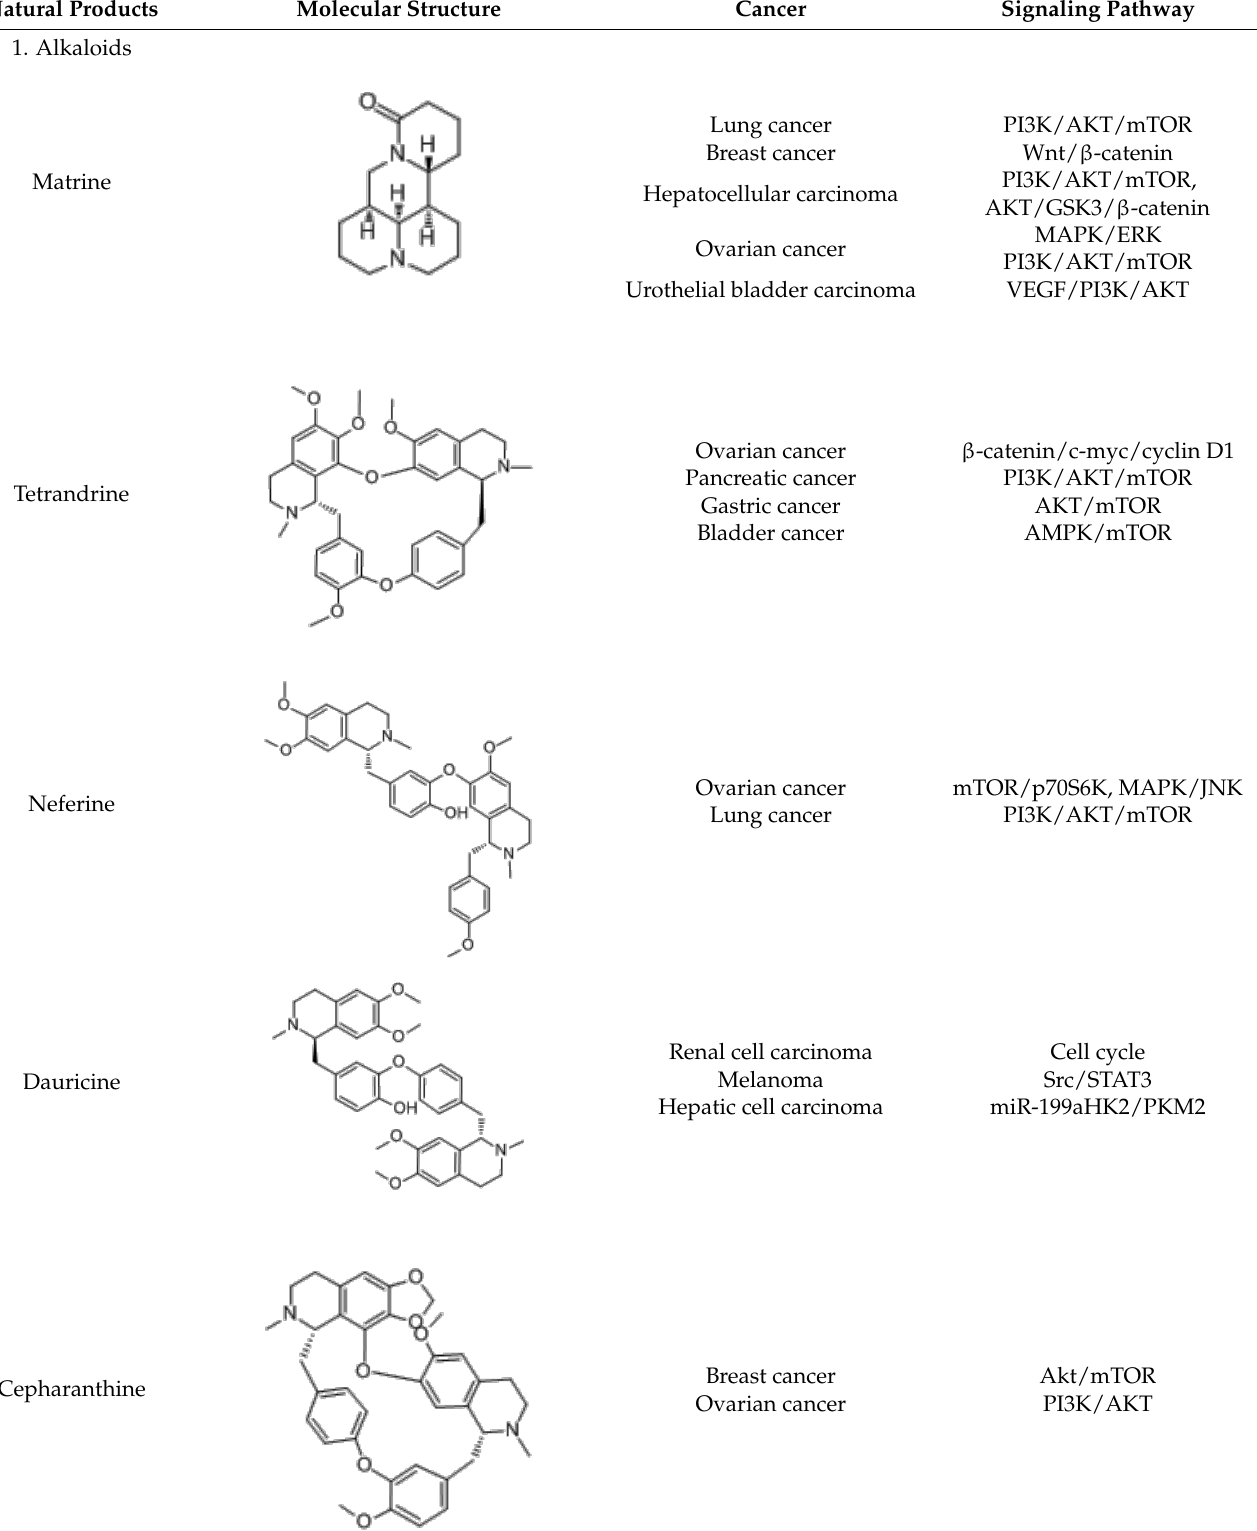
Table 1. Natural products in preventing tumor drug resistance.